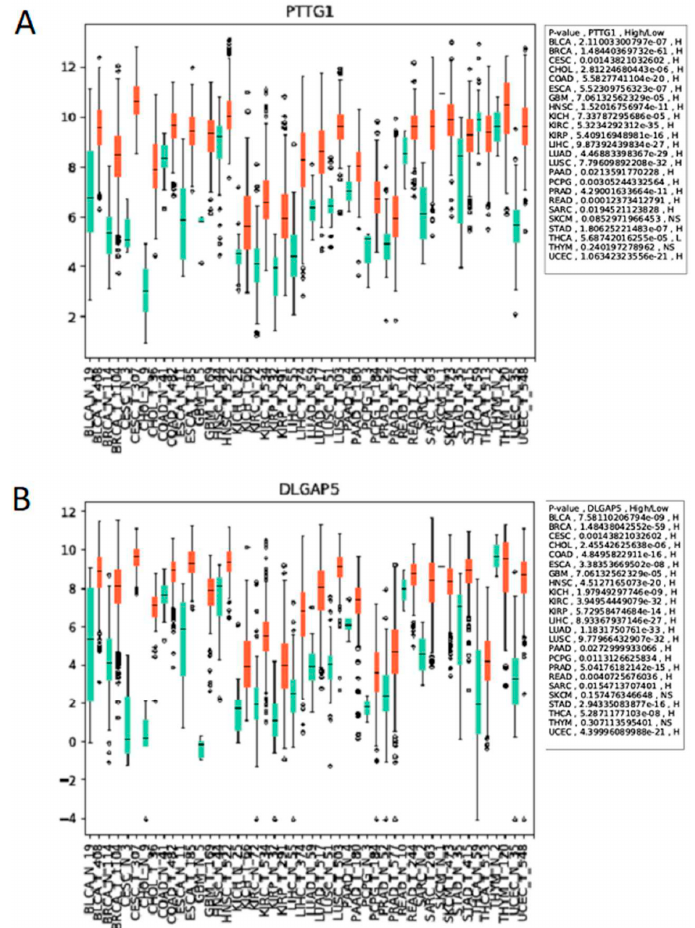
Figure 4 . The APC substrate mRNAs PTTG1 and DLGAP5 are overexpressed in multiple cancer types. Expression scores for ( A ) PTTG1 and ( B ) DLGAP5 within 24 different types of cancer and normal tissue from TCGA [134]. The numbers in x-axis labels denote the number of patient samples in each cancer type. Statistical significance of the difference in expression between the normal and tumor samples is depicted for each cancer type. N.S. not significant. The abbreviation of each cancer in the axis label is represented as described in the TCGA portal [137].